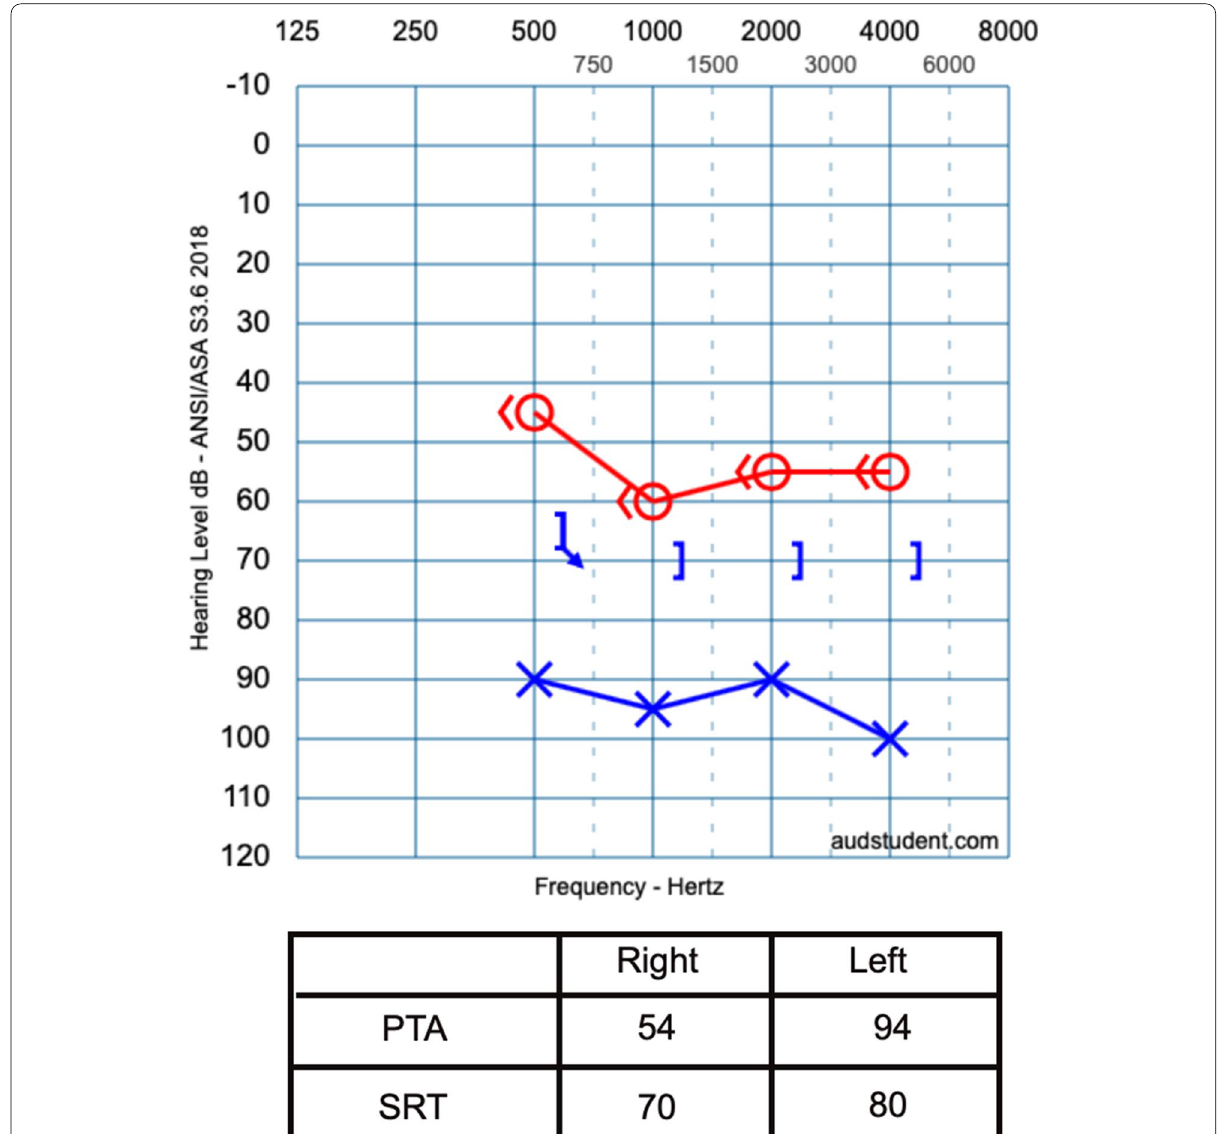
Fig. 3 The result of the initial pure tone audiometry that performed at our clinic on November 29,